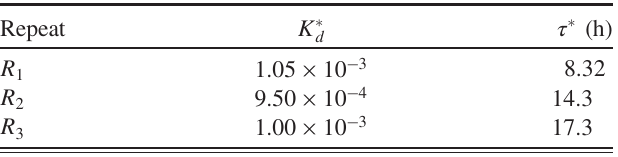
FIG. 7. Schematic representation of an annealing reaction between two filaments of i and j ULFs (green) being blocked by a third one (purple). The size of the ULF is b , and the angle γ represents the minimum angle required for the annealing to take place. If the third filament lies in the shaded circular sector of area A ¼ ð bj Þ 2 θ = 2 , the reaction is